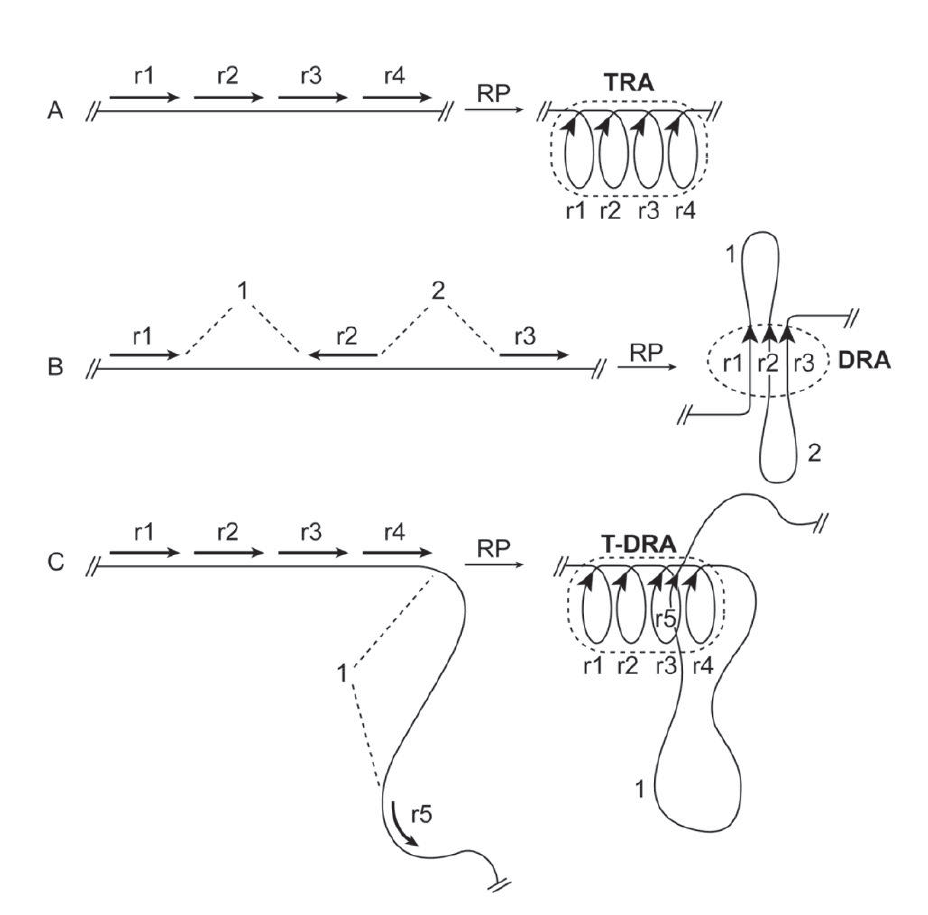
Figure 1. Schematic illustration of different modes of repeat pairing (RP) and RP-mediated chromatin folding. Lines represent chromatin fibers and arrows represent repeats and their orientation on chromatin. Dashed-line loops highlight the paired structures of repeat assemblies (RAs). Although fiber-fiber pairing is depicted in the diagram, it is meant to emphasize the association or interaction of the homologous repeats, rather than the details of pairing. (A) RP among repeats in a tandem array (r1-r4) causes the formation of a tandem repeat assembly (TRA) with a solenoid structure in which adjacent repeats are paired. (B) RP among dispersed repeats (r1-r3) leads to the formation of a dispersed repeat assembly (DRA) and loops from inter-repeat segments (1 and 2). (C) RP among tandem repeats (r1-r4) and their dispersed homologs (r5) results in the formation of tandem- dispersed repeat assembly (T-DRA) and loops